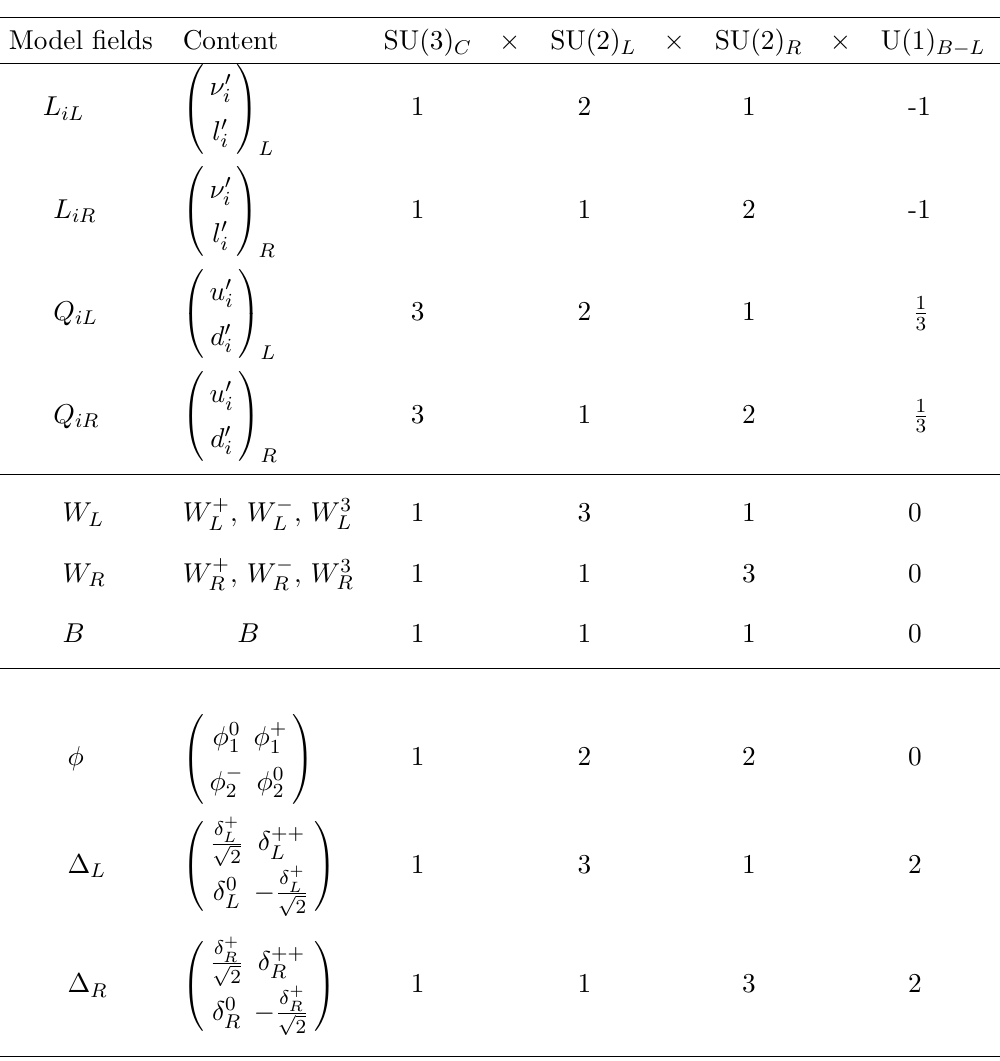
Table 1. The field content in the LRSM and their corresponding quantum numbers. The fermionic fields L and Q represent lepton and quark fields, respectively. The index i = 1 , 2 , 3 of the fermionic fields runs over the number of generations. The 0 symbol of the fermionic fields denotes that these are gauge eigenstates. The Higgs multiplets φ , ∆ L and ∆ R are the bidoublet, the left and the right triplet,